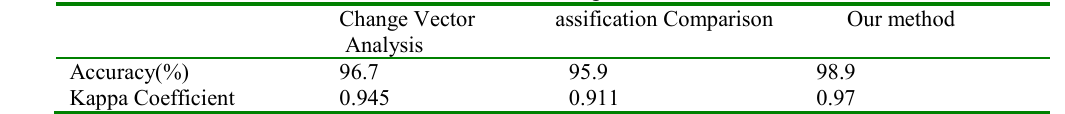
Table 1 Change detection